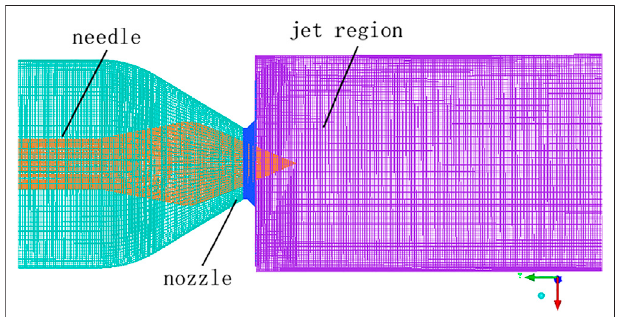
FIGURE 1 | Structure grid of jet mechanism